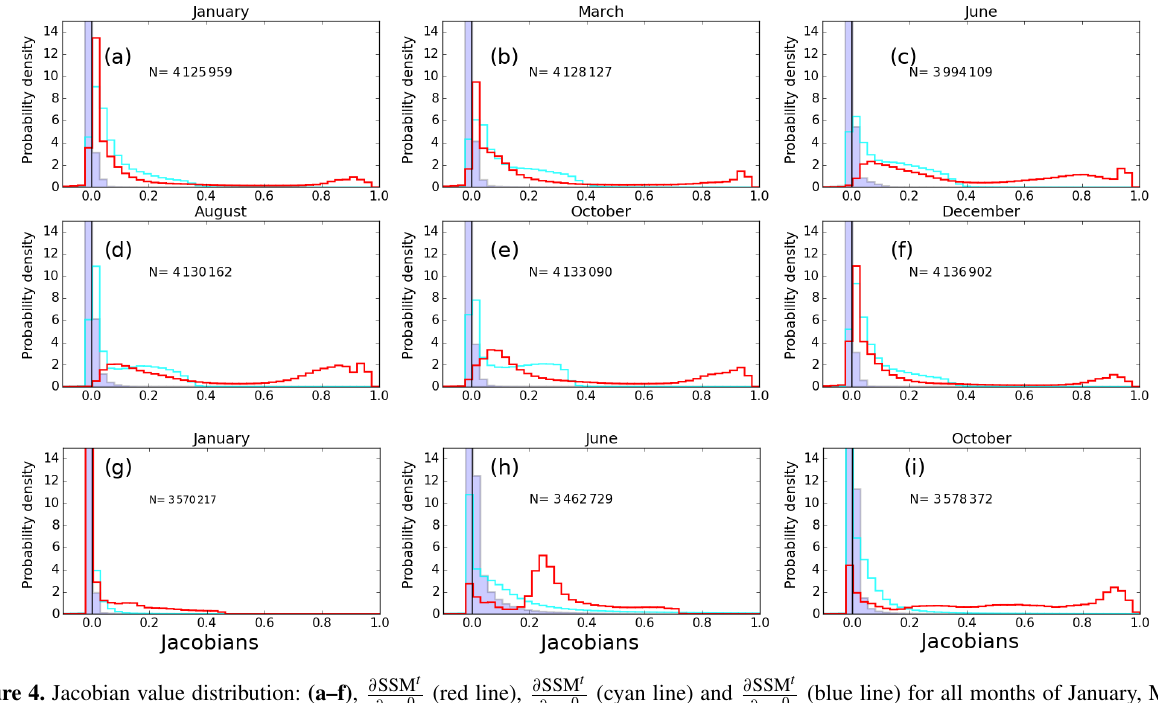
Figure 4. Jacobian value distribution: (a–f) , ∂ SSM June, August, October and December over 2000–2012, (g–i) , ∂ LAI January, June and October over 2000–2012. A black solid line represents a value of